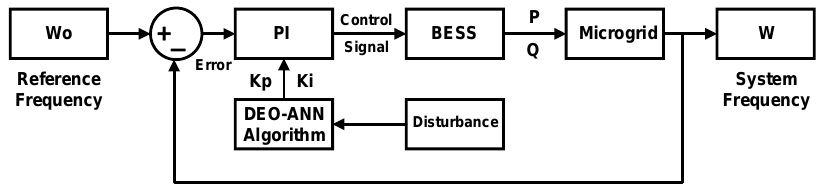
Figure 8. MG control diagram model.